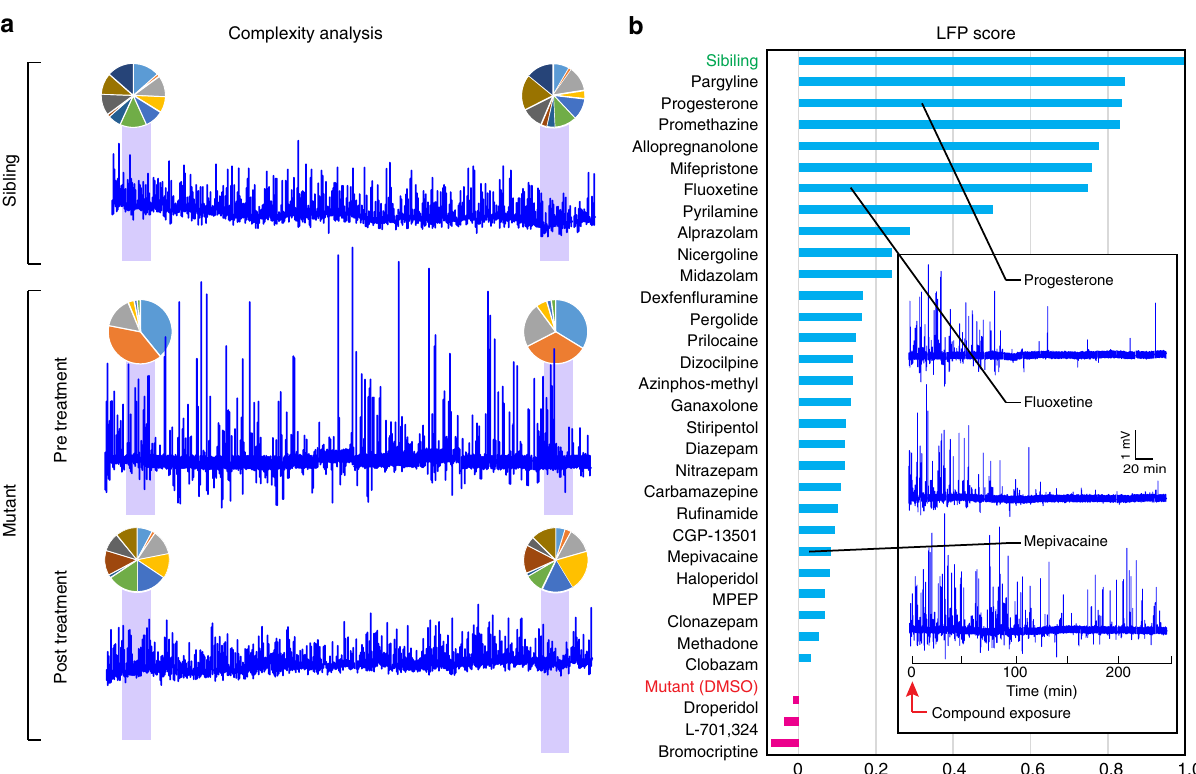
Fig. 3 Screening neuroactive compounds using brain activity patterns. a LFP recordings from a representative sibling control (top), an untreated scn1lab s552 mutant (center) and a mutant beginning at 2 h after exposure to fl uoxetine (bottom). All recordings span 4 h. Pie charts above each recording indicate the relative contribution of each independent component (IC) during the indicated 45 min interval (purple shading). Untreated mutants have low-complexity LFPs made up of only a few dominant ICs, while sibling controls and mutants treated with effective compounds have more complex LFPs that are composed of more equally dominant ICs. b Composite LFP scores at 4-h post treatment for all preliminary hits as well as untreated (1% DMSO) scn1lab mutants and age-matched sibling controls ( n = 5 – 11 per compound). Inset shows representative 4 h LFP recordings from individual scn1lab s552 mutant larvae treated with the indicated compounds beginning at time = 0. The frequency of spontaneous high-amplitude seizure-like spikes diminishes in response to effective compounds (e.g., progesterone and fl